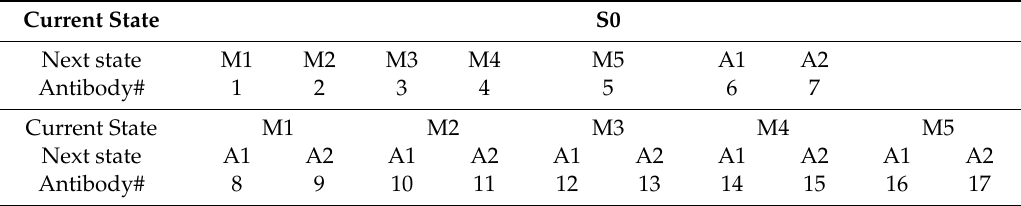
Figure 3. State and state transitions for the FSM of intrusion detection. Some attacks are easy to be captured, and, therefore, the red lines represent direct transitions to final results. Some attacks are elaborate. We have to wait for subsequent information to make the final decision. Each internal state M1 – M5 corresponds to one suspicious attack. The number of states depends on the system resources. Table 2. Assignment of state transition to Table 2. Assignment of state transition to antibodies